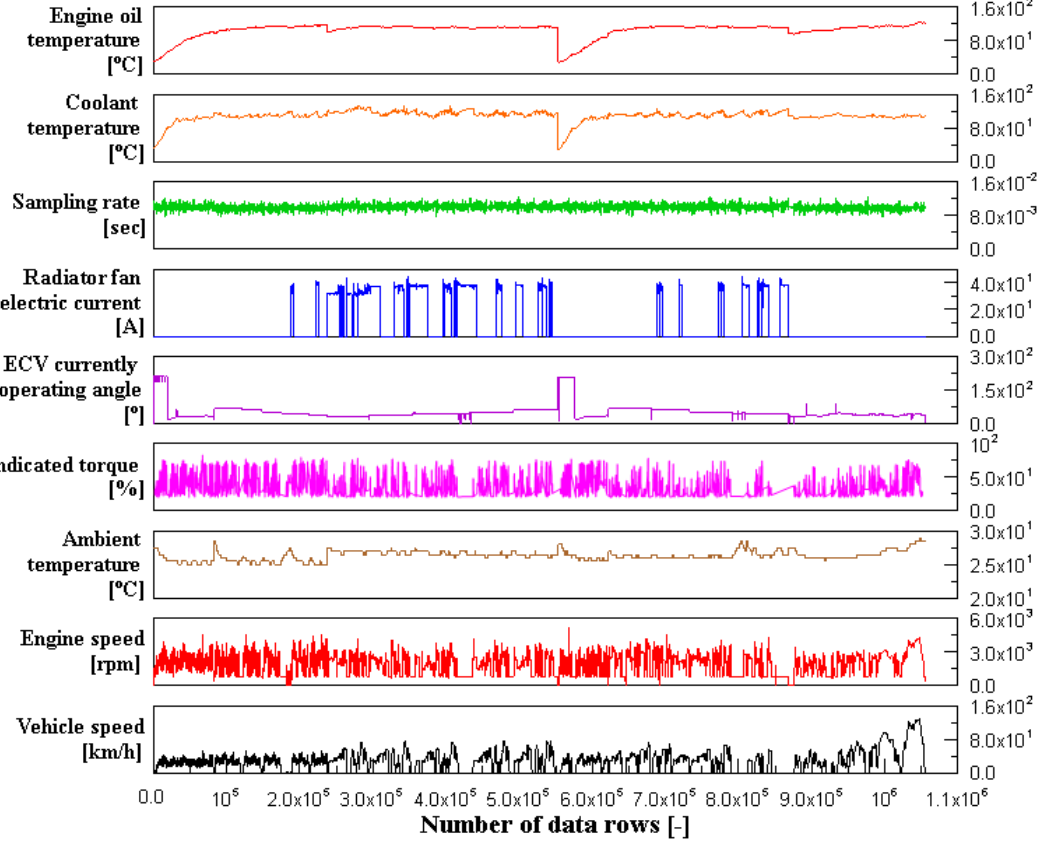
Figure 5. Graph representing samples of the training data for neural network-based model.